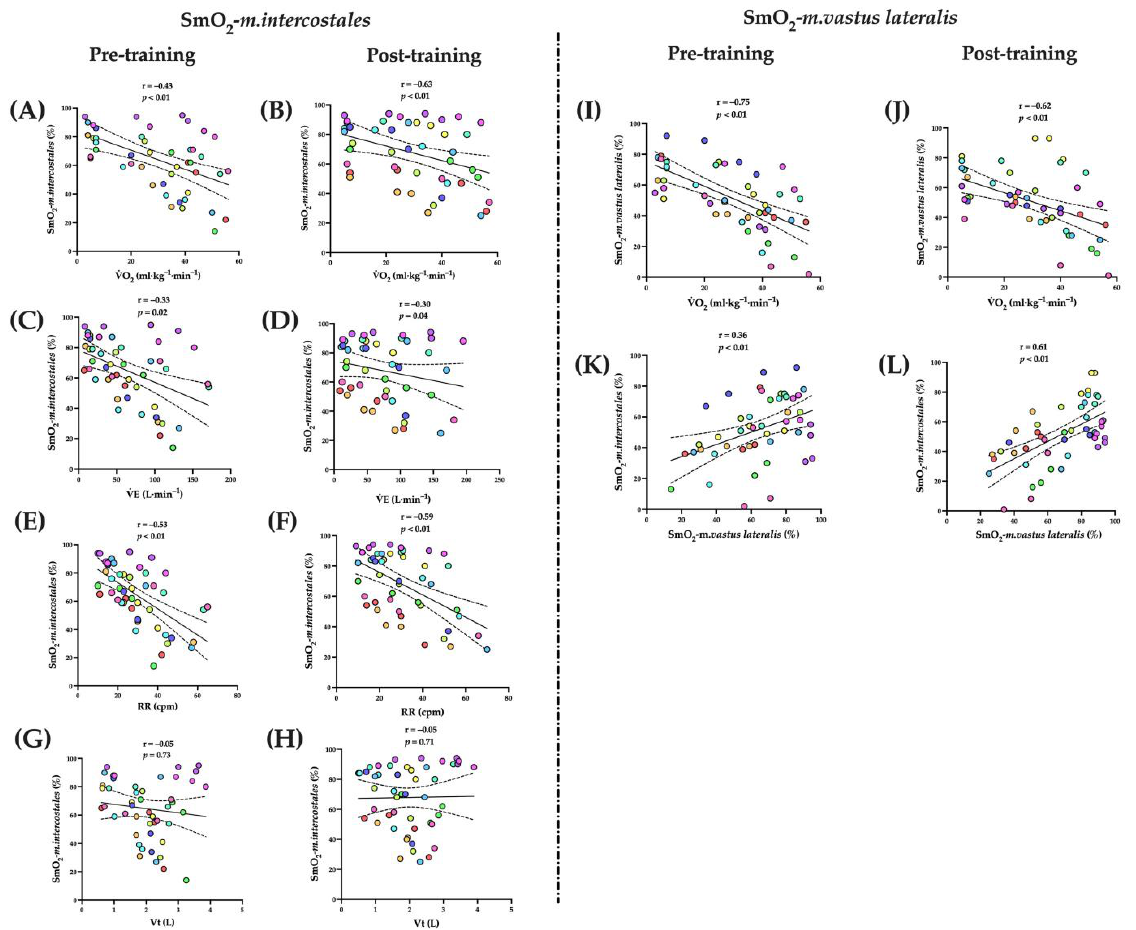
Figure 4. Correlations in VIH group of SmO 2 - M. intercostales (%) with V̇ O 2-peak (ml·kg − 1 ·min − 1 ) in